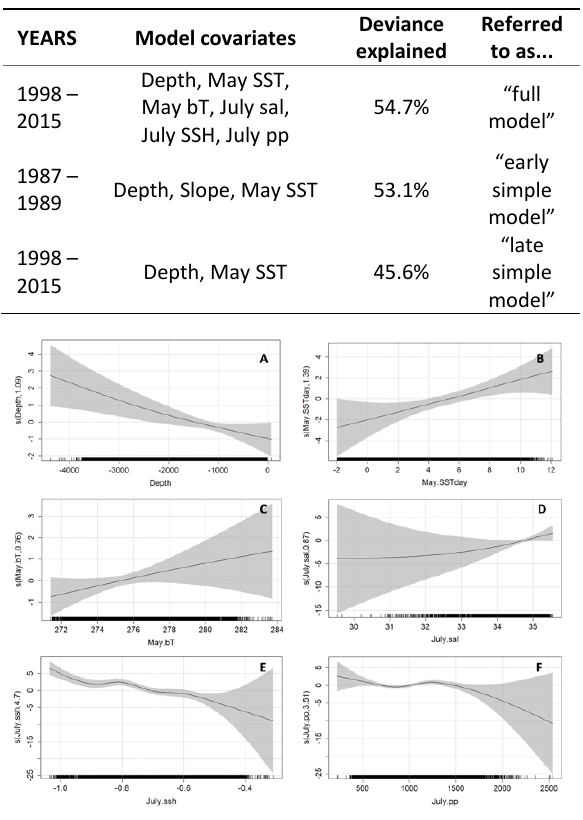
Table 3. Summary of the final models for sei whales. (Abbreviated covariate names described in Table 2).